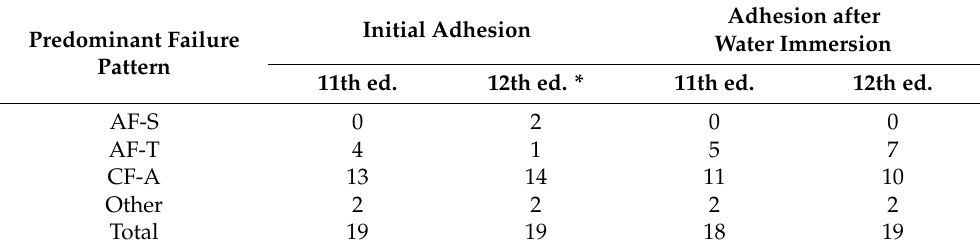
Table 5. The number of the predominant mode of failure for the initial tensile adhesion strength and tensile adhesion strength after water immersion measurements in the eleventh and twelfth ed. of the